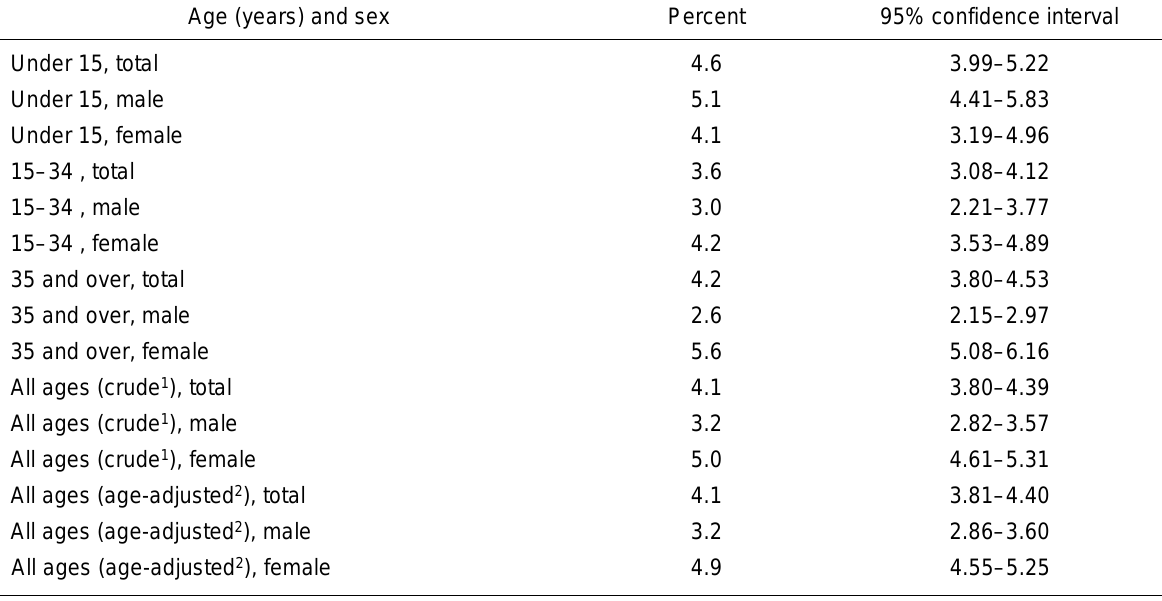
Data table for Figure 15.2. Percentage of persons of all ages who experienced an asthma episode in the past 12 months, by age group and sex: United States, 2016